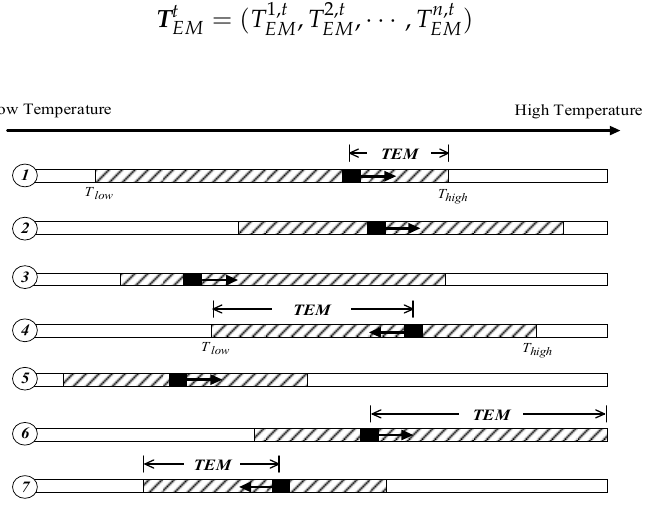
Figure 5. Schematic diagram of temperature extension margin.